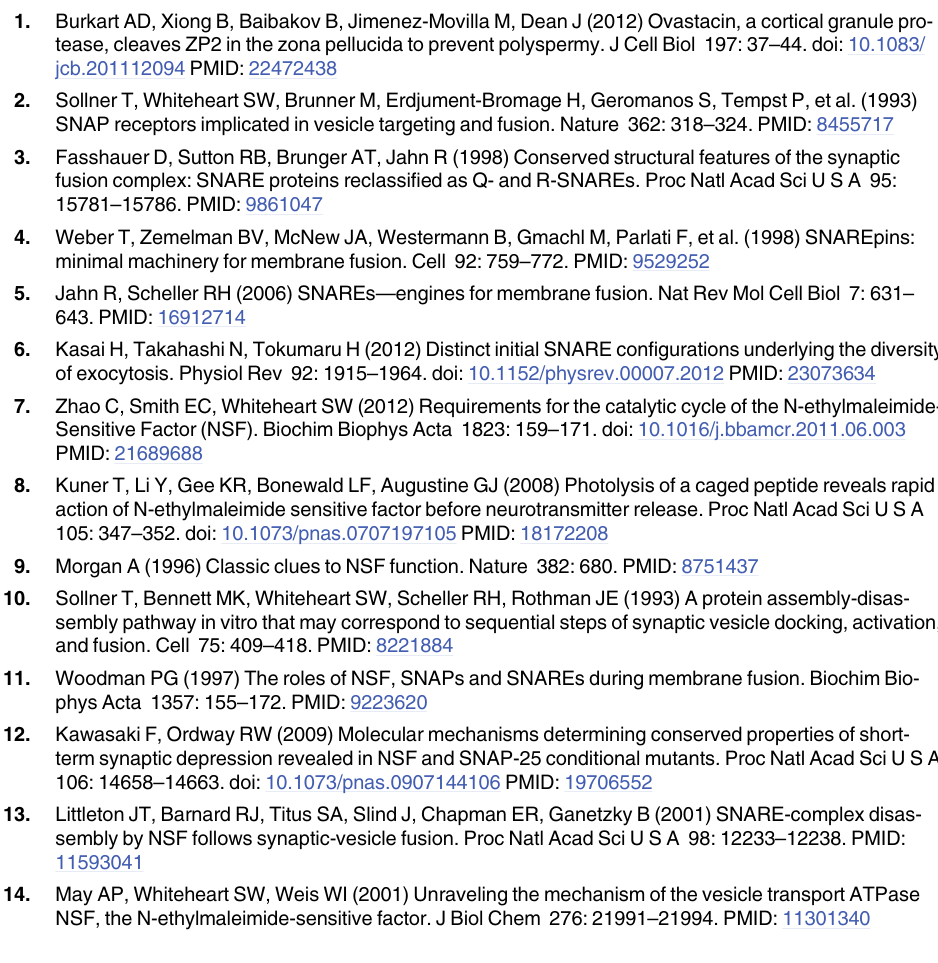
488; red, cortical granules stained with LCA-Rhodamine; blue, DNA labeled with Hoechst 3342. Differential interference contrast (DIC) images are shown on the right of each panel. The last row of all panels shows negative cell staining when the primary antibody was not used. Scale bar: 20 μ